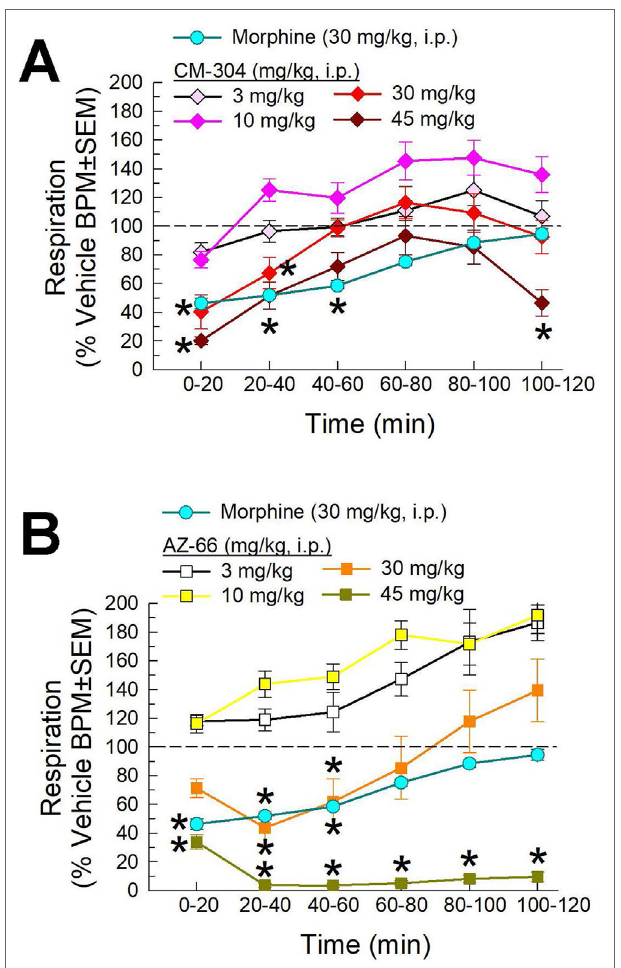
FIGURE 9 | Dose- and time-dependent respiratory effects of i.p. administration of (A) CM-304 or (B) AZ-66 evaluated in the CLAMS assay with C57BL6/J mice. Morphine (30 mg/kg, i.p.) included as a positive control. * = significantly different from vehicle effect (dashed line), p < 0.05; two-way ANOVA w/Dunnett’s post hoc test. N = 10–20 mice/group.